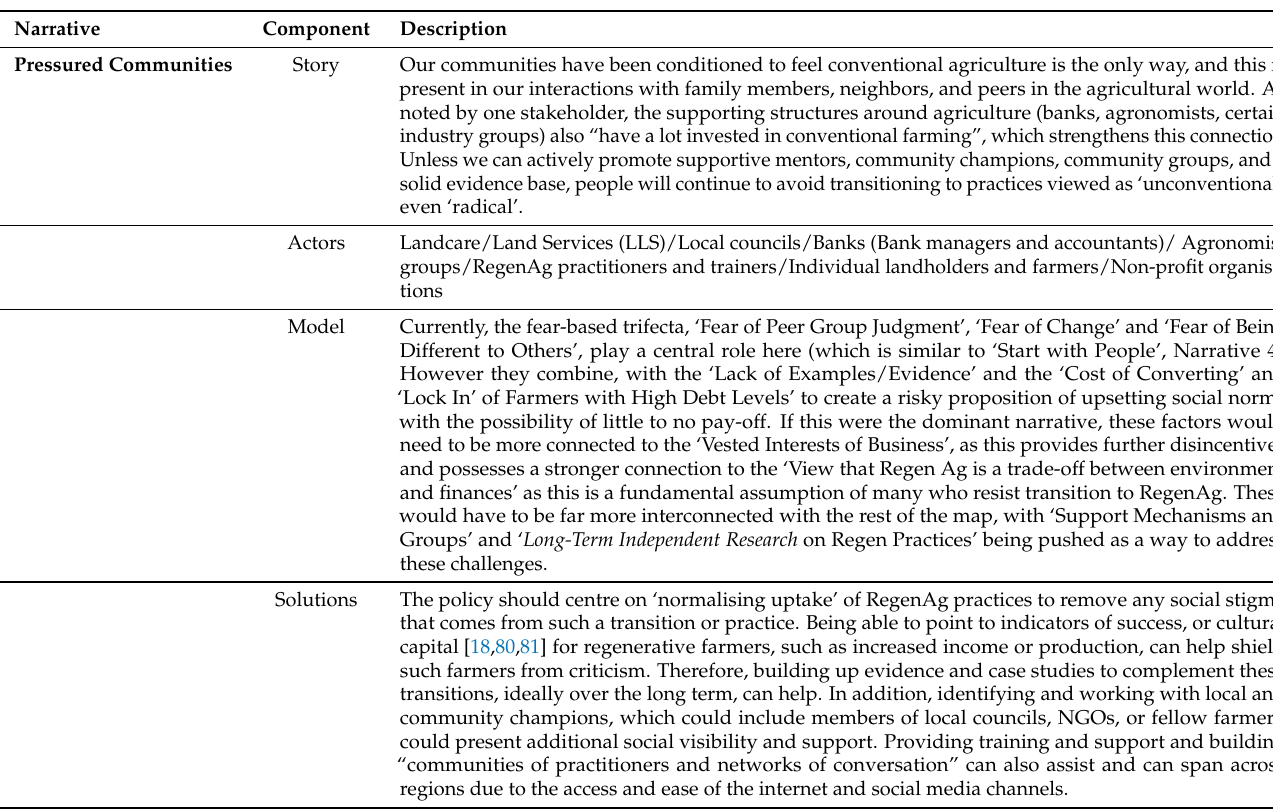
Table 5. Narrative 3: Pressured Communities.